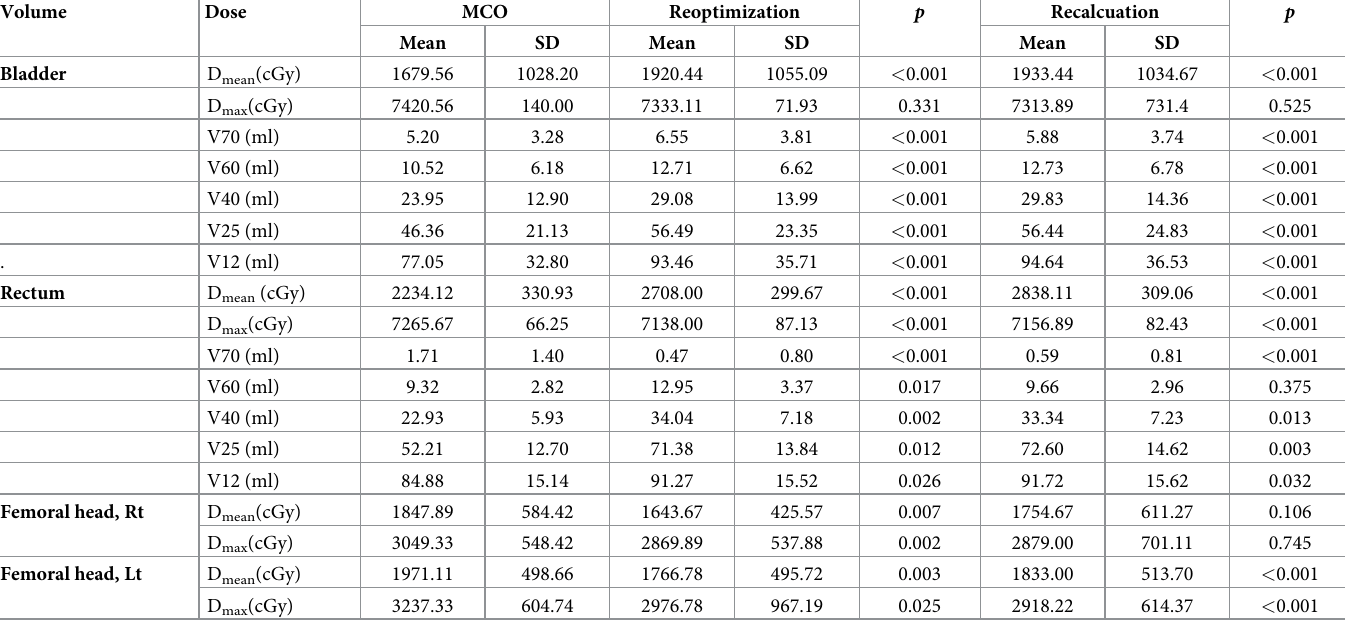
Table 4. Dose–volume statistics of OARs with MCO, reoptimization, and recalculation. Volume